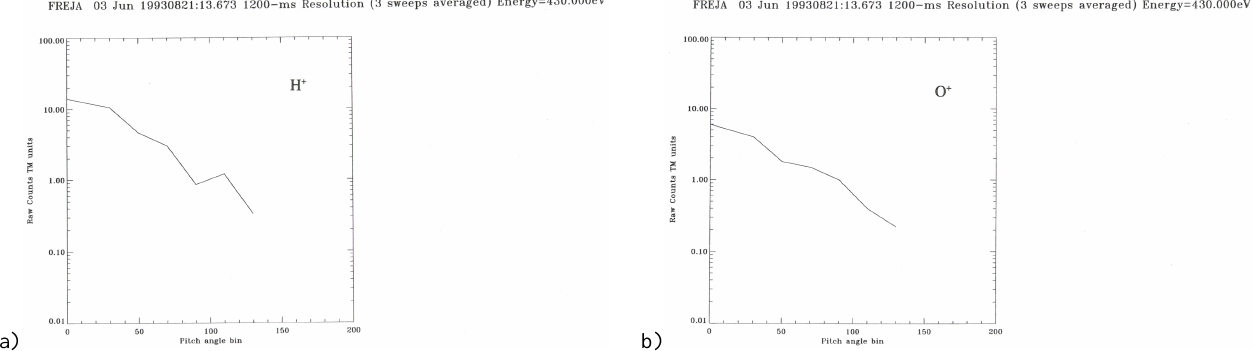
Fig. 4. Pitch-angle distributions of H + (a) and O + ions (b) with an energy of 430eV observed at the same time in orbit 3172 as the energy spectra in Fig. 3 were measured. As can be seen, the count rates at low pitch-angles are an order of magnitude higher than around 90 ◦ .